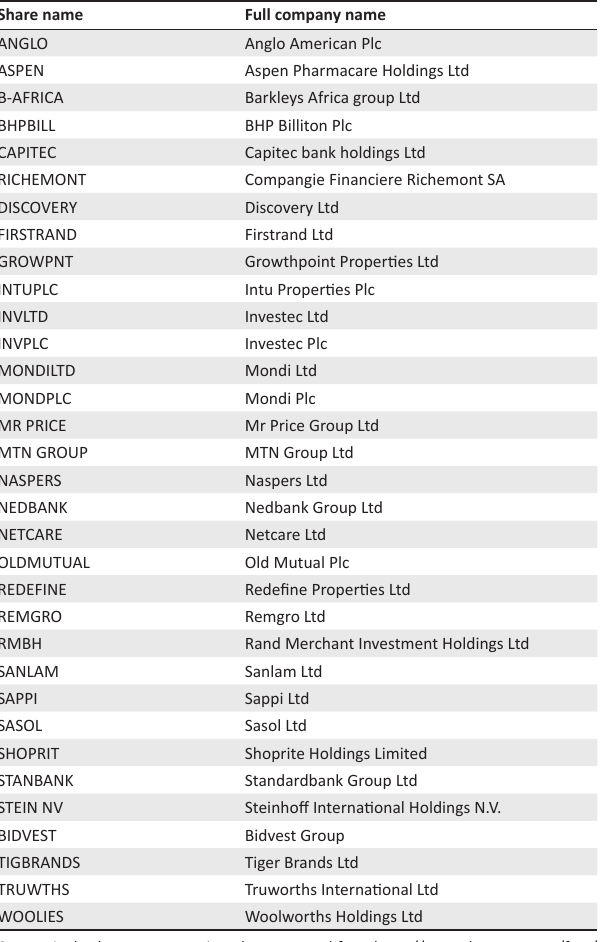
TABLE 1-A1: List of sample companies used in